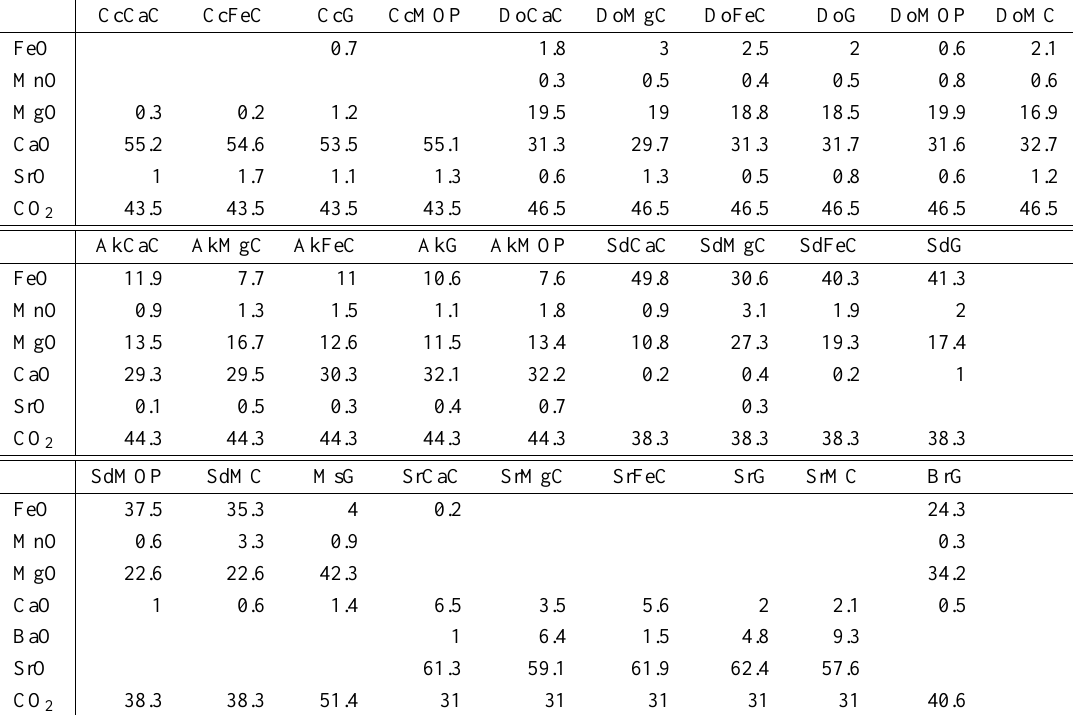
Representative carbonate analyses of Araxá